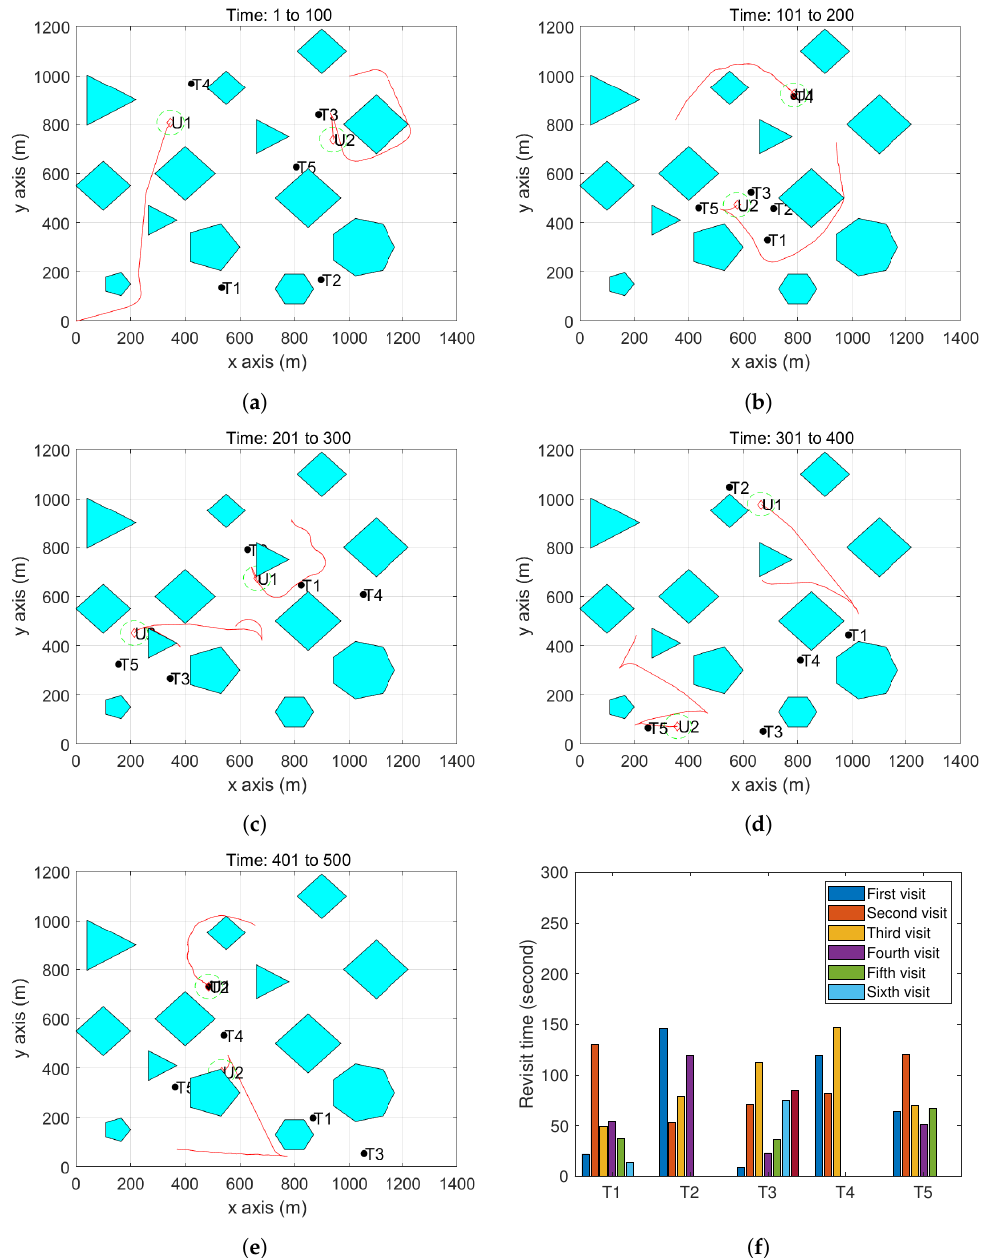
Figure 10. The trajectories of two UAVs flying at 10 m/s. ( a ) The UAV trajectory between 1 and 100 s. ( b ) The UAV trajectory between 101 and 200 s. ( c ) The UAV trajectory between 201 and 300 s. ( d ) The UAV trajectory between 301 and 400 s. ( e ) The UAV trajectory between 401 and 500 s. ( f ) The revisit time of each target during the